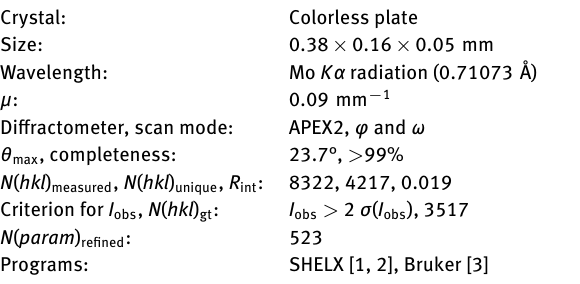
Table 1: Data collection and